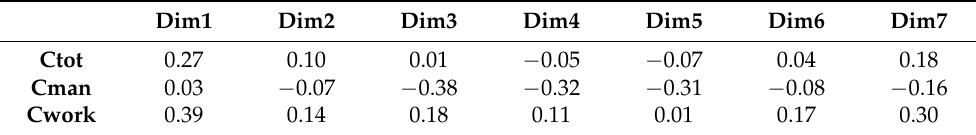
Table 8. Pearson’s correlation indexes between the output of the COVID-19 questionnaire and that of NOSACQ-50 1 . Dim1 Dim2